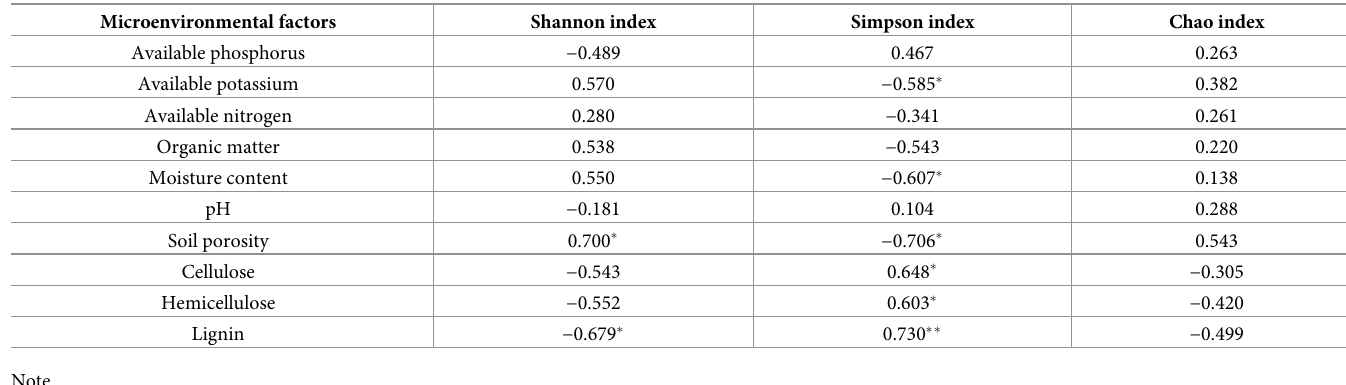
Table 2. Correlations between microenvironmental factors and diversity index at OTU